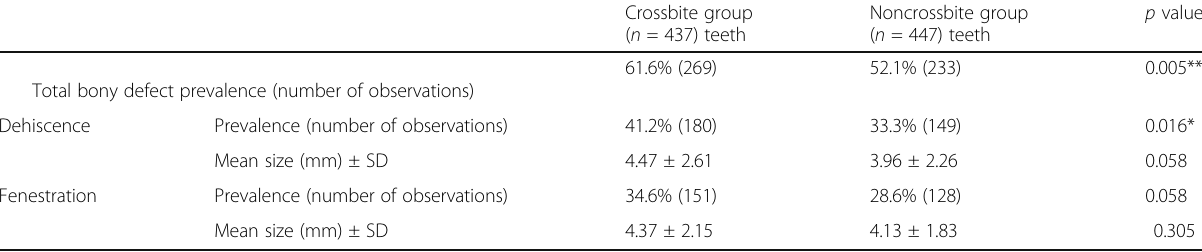
Table 4 Prevalence and mean size of total bony defects, dehiscence, and fenestration in the study group (crossbite group) and comparison group (noncrossbite